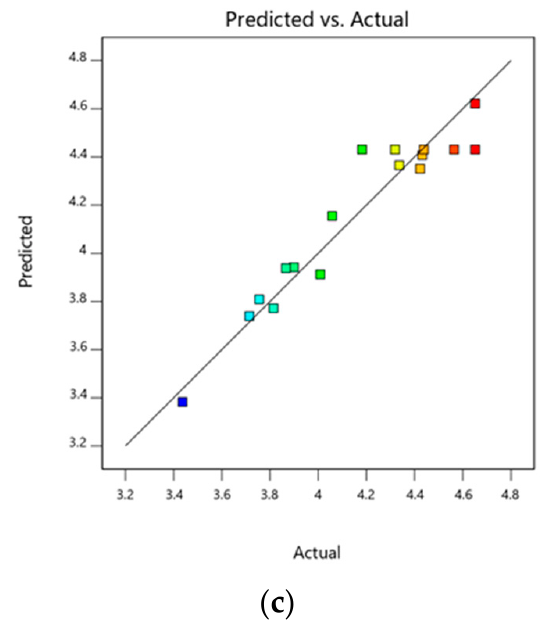
Figure 4. ( a ) The normal probability plot of residuals, ( b ) plot of internally studentized residuals versus experimental runs, and ( c ) plot of predicted and actual values.